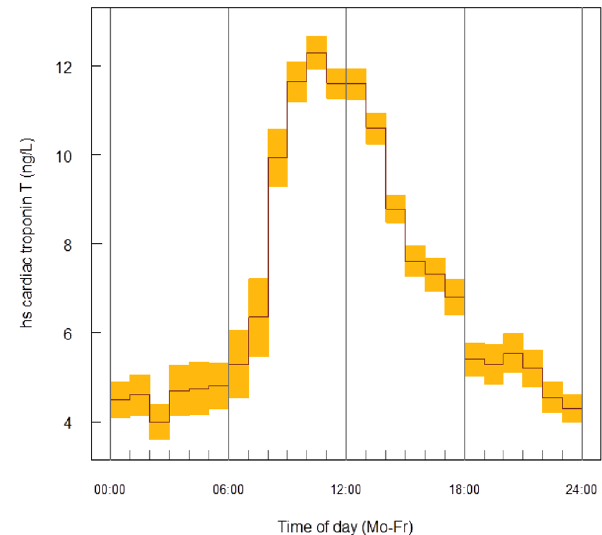
Figure 4: Diurnal variation of the high sensitive cardiac troponin T (hs cardiac troponin) concentration in heparinised plasma (ambulant